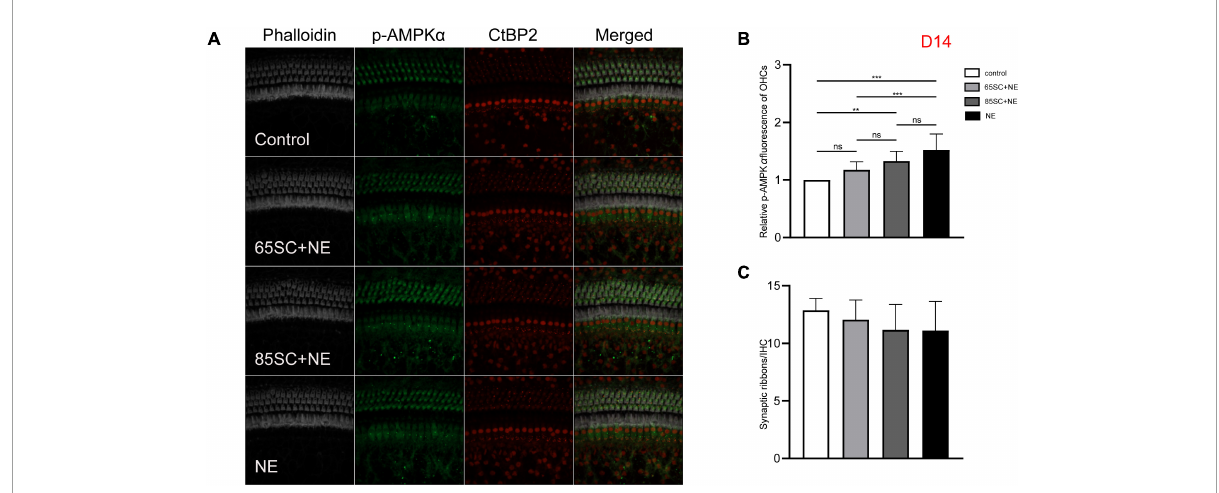
FIGURE8 The p-AMPK α fluorescence intensity and the number of ribbon synapses returned to normal at D14. (A) The p-AMPK α fluorescence intensity and the number of synapses of the four groups at D14. (B) The p-AMPK α fluorescence intensity of the NE group was higher than that of the control ( p < 0.001) and the 65SC+NE group ( p < 0.01), the p-AMPK α fluorescence intensity did not differ between the 65SC+NE group and the 85SC+NE group ( p > 0.05). (C) The number of synapses did not differ between the noise exposed animals and the controls ( p > 0.05). ** p < 0.01, *** p <